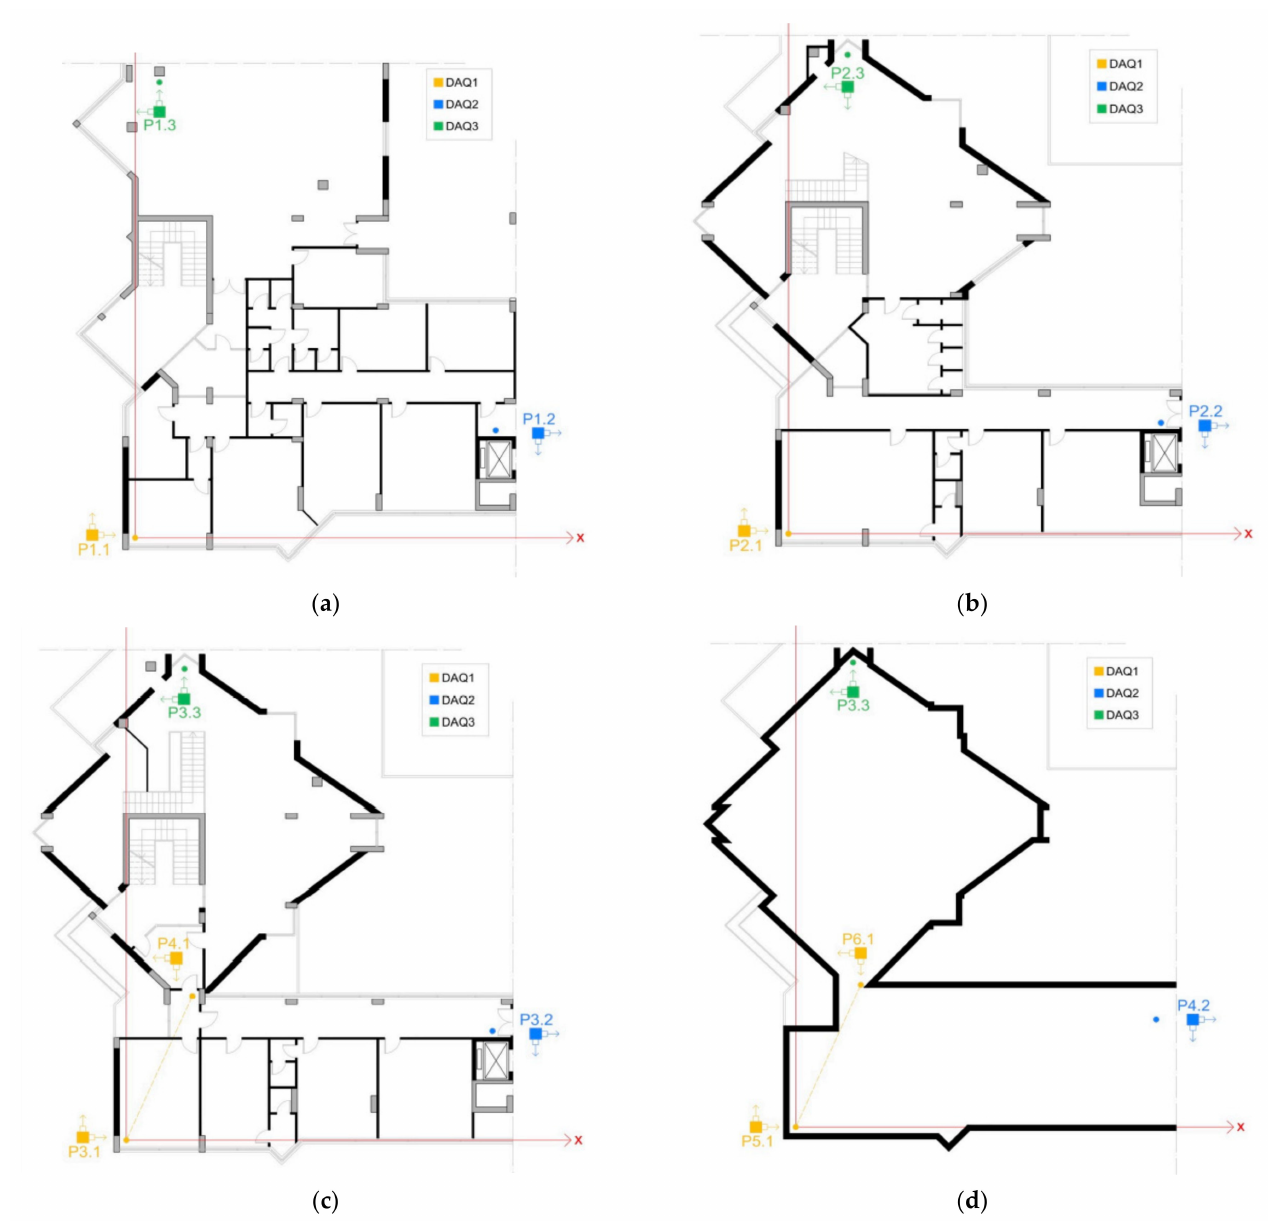
Figure 7. View of the directions of acquisition of the accelerometers installed at the Raised floor ( a ), the First floor ( b ), the Second floor ( c ) and the Roof floor ( d